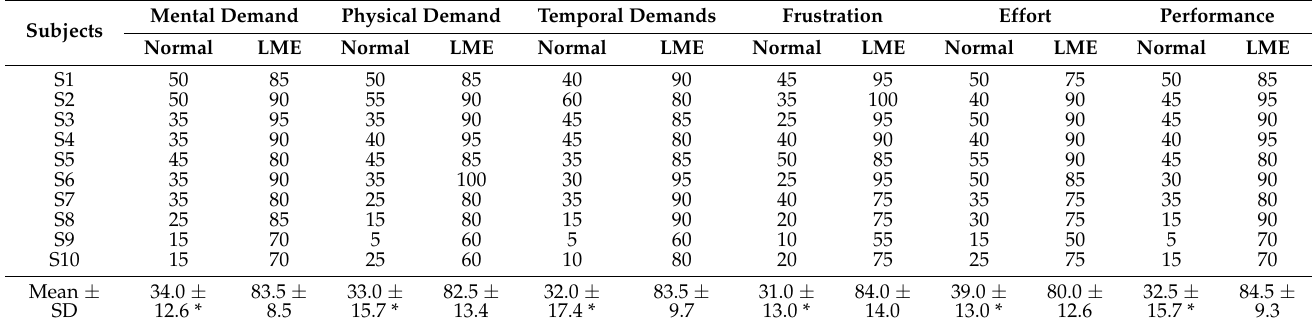
Table 3. Overall Scores from the NASA-TLX.